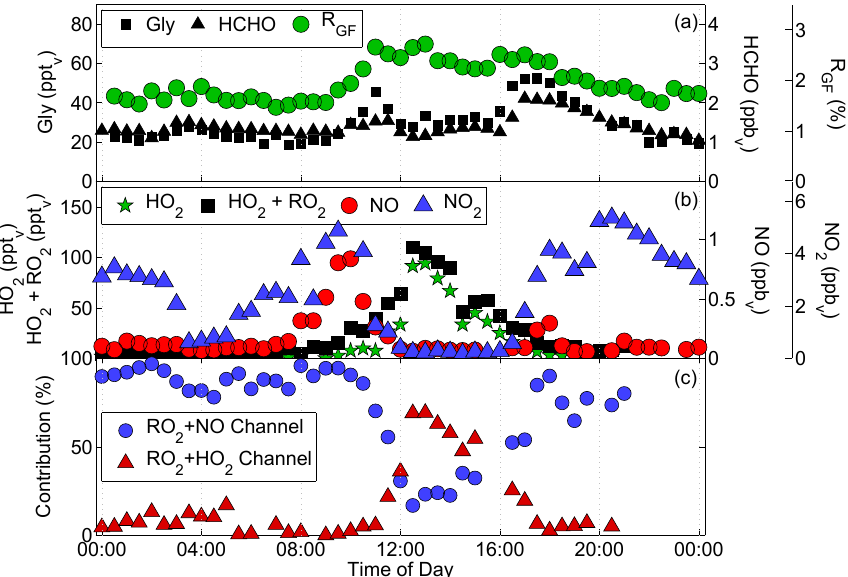
Fig. 8. Examination of RO 2 fate and its relation to HCHO, Gly, and R GF on 24 August during BEACHON-ROCS. (a & b) Thirty minute binned medians of R GF and concentrations of Gly, HCHO, NO, NO 2 , HO 2 , and HO 2 +RO 2 over the course of the day. (c) Thirty minute binned medians of the percent of RO 2 loss from reaction with NO or HO 2 based on concentrations in (b) and rate constants from the IUPAC